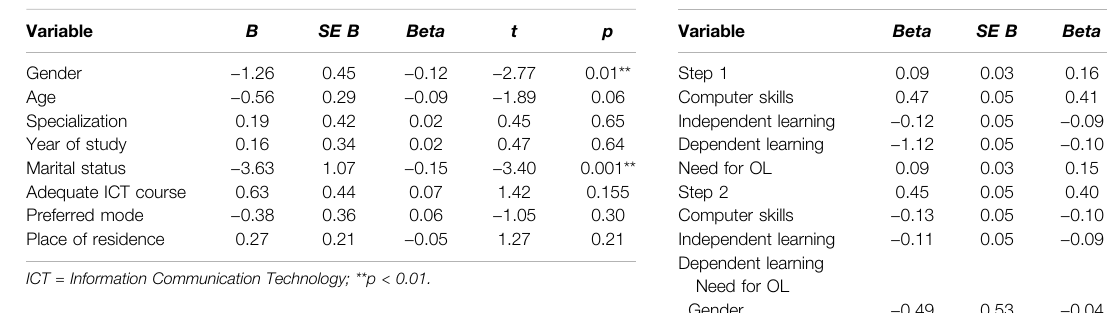
TABLE 8 | Hierarchical multiple regression analysis relating to academic